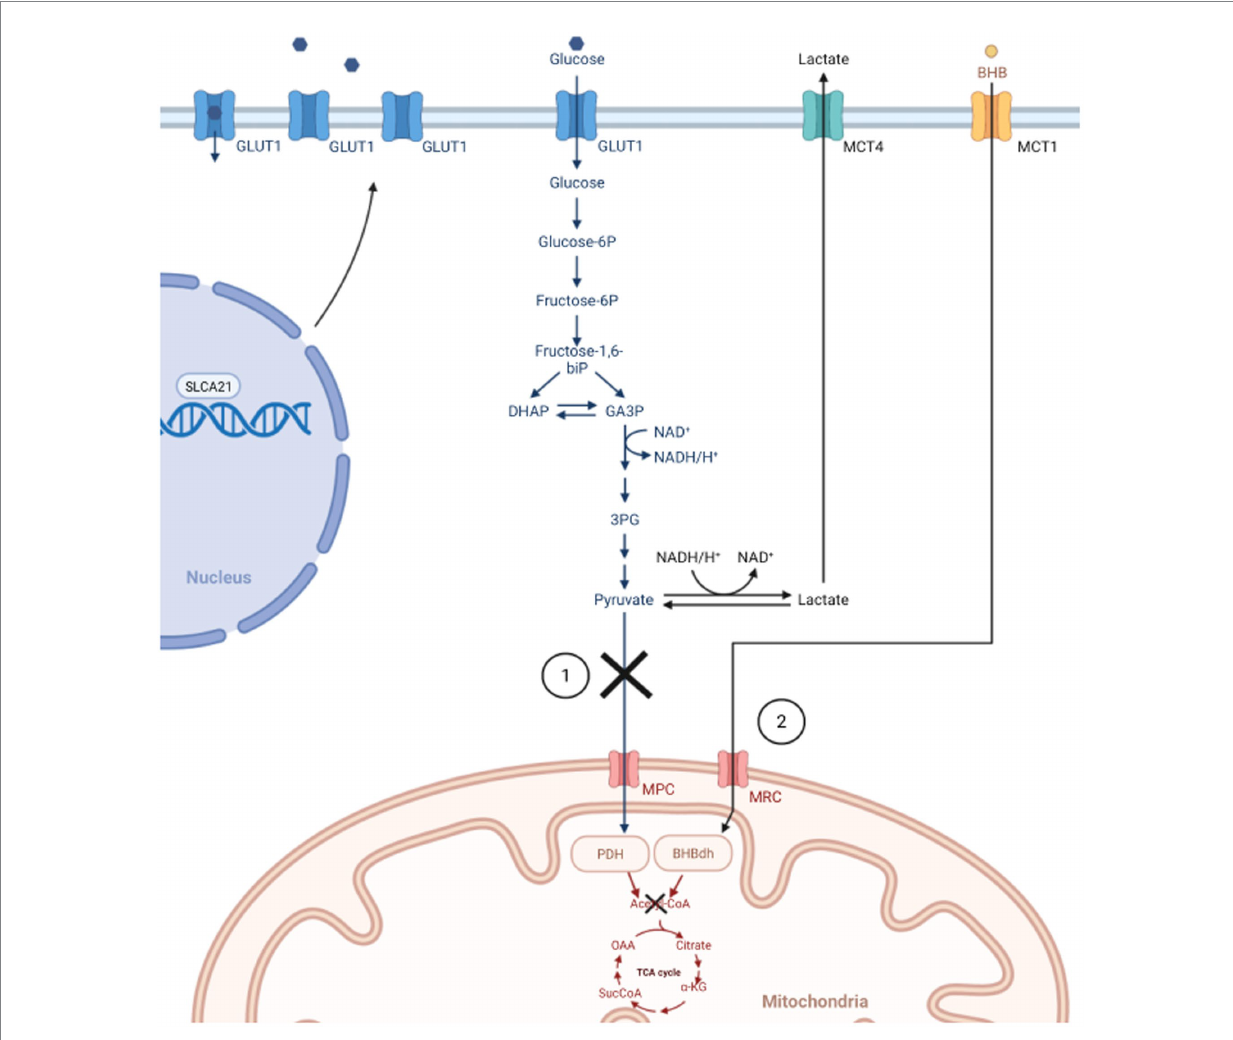
FIGURE 1 In normal cells, glycolysis only occurs in the cytoplasm under anaerobic conditions, which generates small amounts of energy. During aerobic conditions, normal cells prefer the TCA cycle and oxidative phosphorylation through the mitochondria. The Warburg Effect states that cancer cells prefer “aerobic glycolysis” for faster, safer energy production due to defective mitochondria. 1) In normal cells, pyruvate would be converted into Acetyl-CoA to start the TCA cycle. Due to dysfunctional mitochondrion (e.g., downregulated MPC, inhibition of PDH), cancer cells convert pyruvate to lactate to drive energy production. Subsequently, lactate is transported out of the cell via MCT, thus increasing the need for cancer cells to upregulate the SLCA21 gene to increase production of GLUT1 transporters allowing more glucose into the cell. 2) In healthy endothelial cells of the brain, BHB can be converted into Acetyl-CoA to facilitate the TCA cycle when glucose is low. Warburg states the process is not possible in cancer cells, and the reason for utilizing ketogenic diets in treating GBM. GLUT1, glucose transporter 1; DHAP, di-hydroxy acetone phosphate; GA3P, glyceraldehyde 3-phosphate; CoA, Coenzyme A; TCA, tricarboxylic acid; MPC, mitochondrial pyruvate carrier; PDH, pyruvate dehydrogenase; SLCA21, Solute Carrier Family 2 Member 1; MCT, Monocarboxylate transporter; BHB, β -hydroxybutyrate; MRC, mitochondrial respiratory complex; BHBdh, β -hydroxybutyrate dehydrogenase. Created with